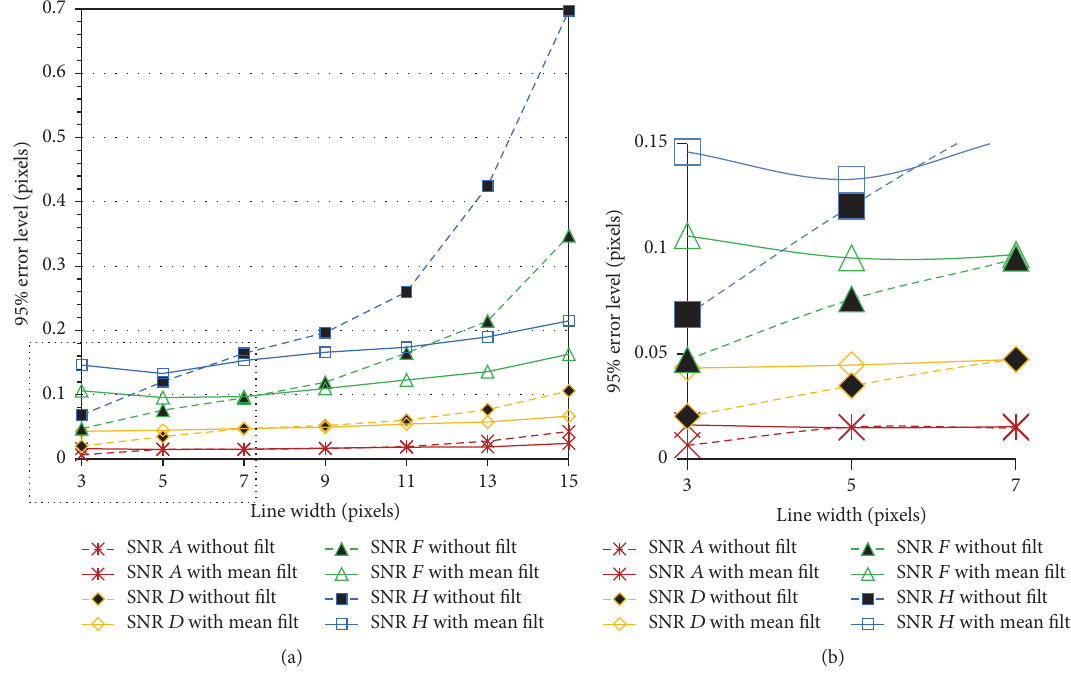
Figure 12: (a) Error levels for different SNR values and various line widths with and without employing a 5 × 5 window mean filter and (b) magnified view of the section highlighted in